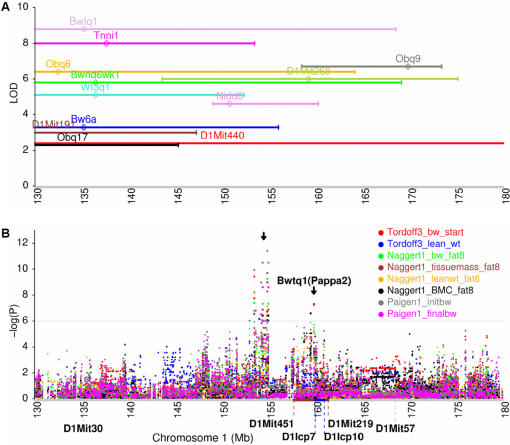
Dissection of multiple tightly linked QTLs.(A) Obesity QTLs were mapped to distal mouse hromosome 1 by linkage analysis from cross-breeding experiments [10]. Approximately one LOD interval was plotted against its LOD at the QTL peak. The diamonds indicate QTL peaks. Each peak lists the names of the defined QTL. (B) LD mapping of several obesity-related phenotypes in distal mouse chromosome 1. LD mapping identified two closely linked QTLs on distal chromosome 1. One is located within 153.5–155.5 Mb; another reproduced the previously refined QTL, Bwtq1. The analyzed phenotypes are body weight at the start of testing (8 weeks) (Tordoff3_bw_start), calculated weight of lean tissue (14 weeks) (Tordoff3_lean_wt), body weight after 8 weeks on an atherogenic diet (Naggert1_bw_fat8), total tissue mass after 8 weeks on an atherogenic diet (Naggert1_tissuemass_fat8), weight of lean portion of tissue mass after 8 weeks on an atherogenic diet (Naggert1_leanwt_fat8), bone mineral content after 8 weeks on an atherogenic diet (Naggert1_BMC_fat8), initial body weight (7–9 weeks) (Paigen1_initbw), and final body weight after 8 weeks on an atherogenic diet (Paigen1_finalbw).